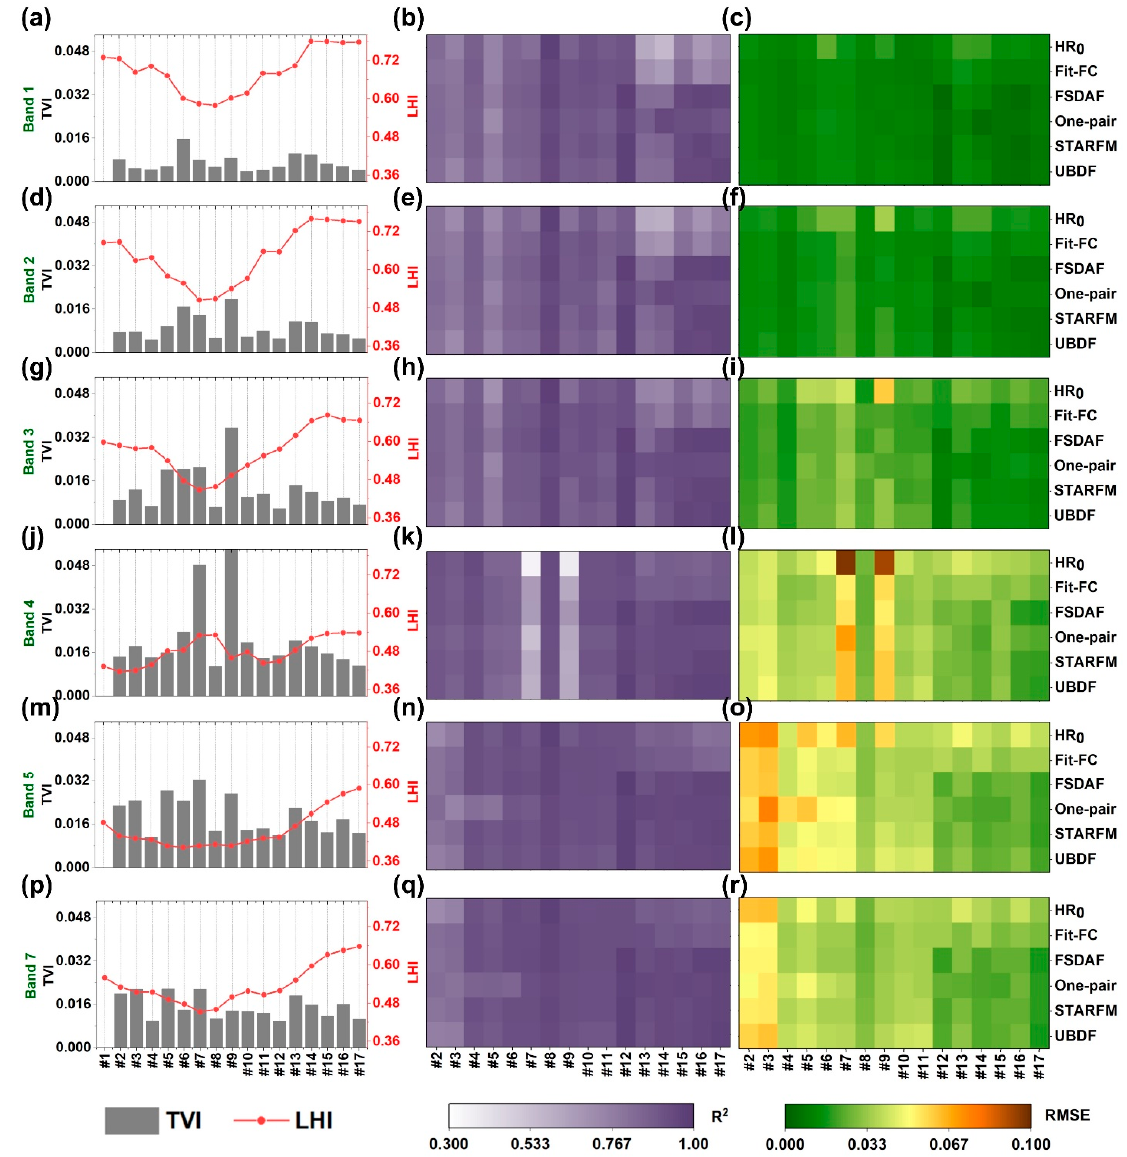
Figure 7. Time series plot of TVI and LHI ( a , d , g , j , m , p ) and metrics of R 2 ( b , e , h , k , n , q ) and RMSE ( c , f , i , l , o , r ) of each method for band 1, 2, 3, 4, 5, 7 (from top row to bottom row) for the whole Coleambally site. “HR 0 ” denotes R 2 and RMSE between target image and the prior image. The abscissa of all statistical charts is the image number in chronological order.